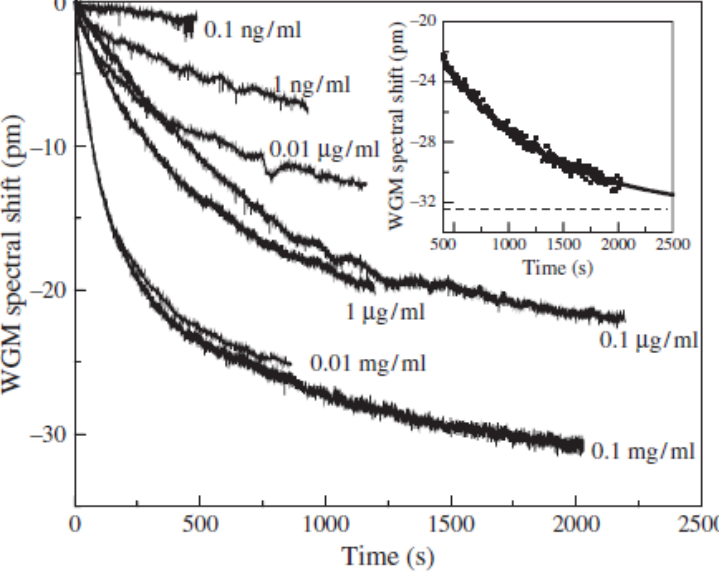
Figure 12. Sensorgrams for BSA cleavage at various concentrations of trypsin. Inset: exponential fit decay for the 0.1 mg/mL curve in the time range of 400–2,000 s; the decay constant is 950 s, and the dashed line indicates the baseline (−32.6 pm). Reproduced with permission from [48] ©2005 American Scientific